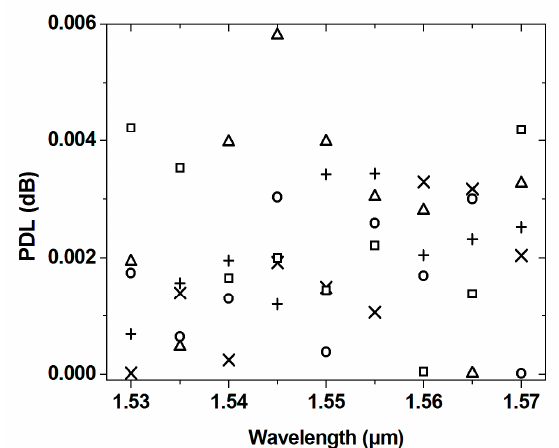
Figure 6. Variations of the polarization dependent loss with wavelengths between 1.53 and 1.57 µm. The symbols of splitting ratio: △ 50:50; + 60:40; × 70:30; □ 80:20; ○ 90:10.